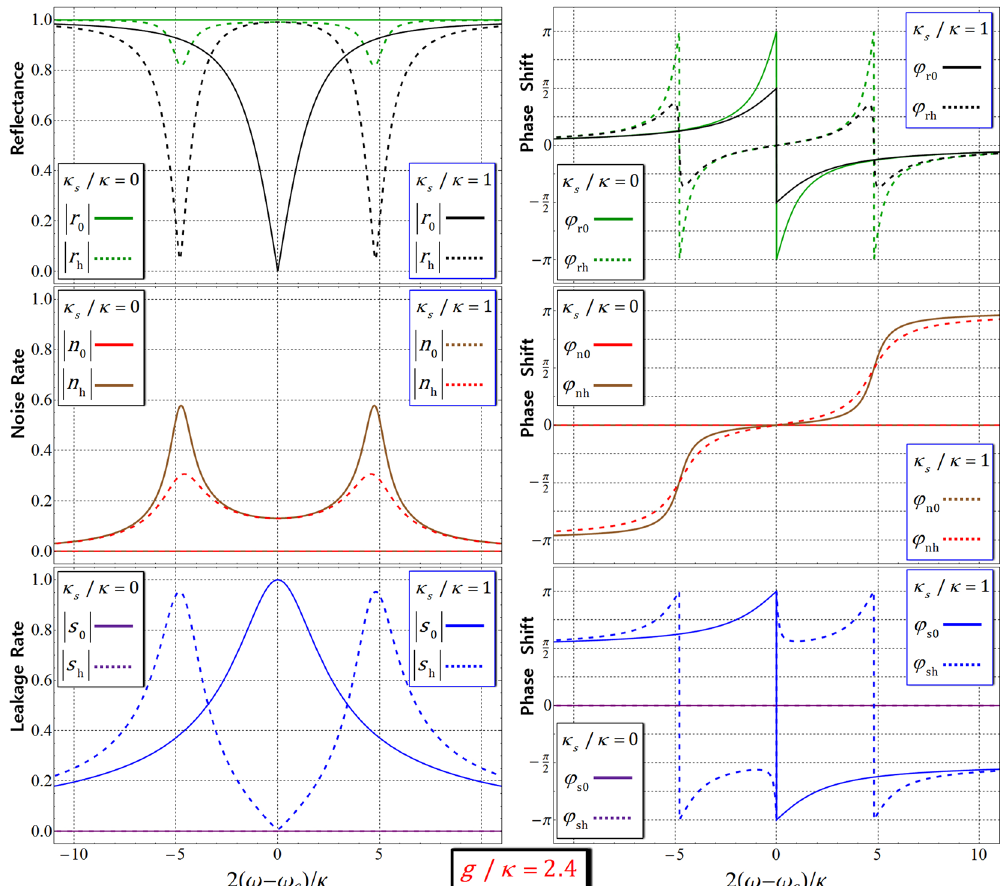
Figure 4. The left figures represent the reflectances [| r h ( ω )|, | r 0 ( ω )|], the noise rates [| n h ( ω )|, | n 0 ( ω )|], and the leakage rates [| s h ( ω )|, | s 0 ( ω )|], and also the right figures represent the phase shifts [ ϕ rh ( ω ), ϕ r0 ( ω ), ϕ nh ( ω ), ϕ n0 ( ω ), ϕ ω ), ϕ ω )] for frequency detuning 2( ω − ω κ , according to the difference in the side leakage rates ( κ sh ( s0 ( c )/ and κ s = 1.0 κ ). In these plots, we take the parameters as g / κ = 2.4 and γ / κ = 0.1 ( g > ( κ , γ )) with ω